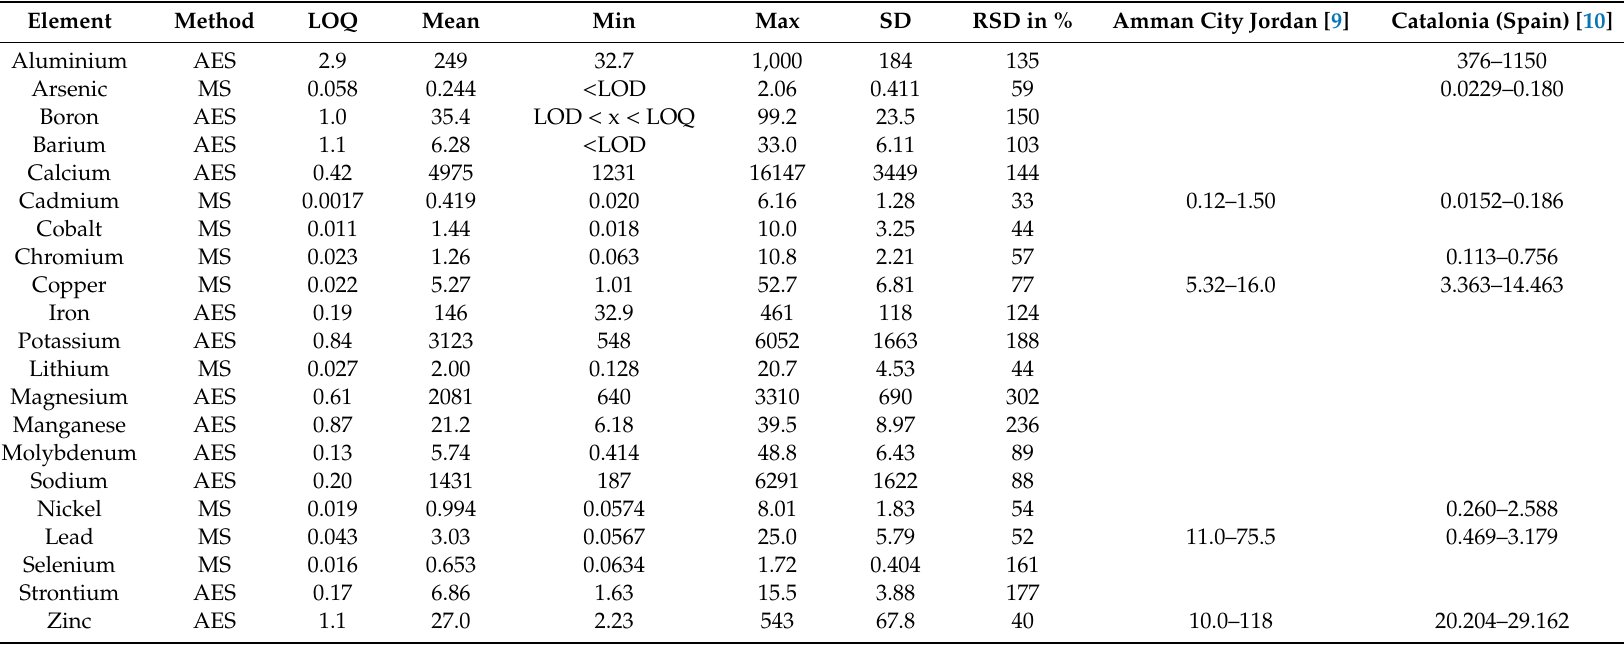
Table 2. Elemental contents in Aleppo pine needles for all sampling sites in mg / kg dry matter alongside literature